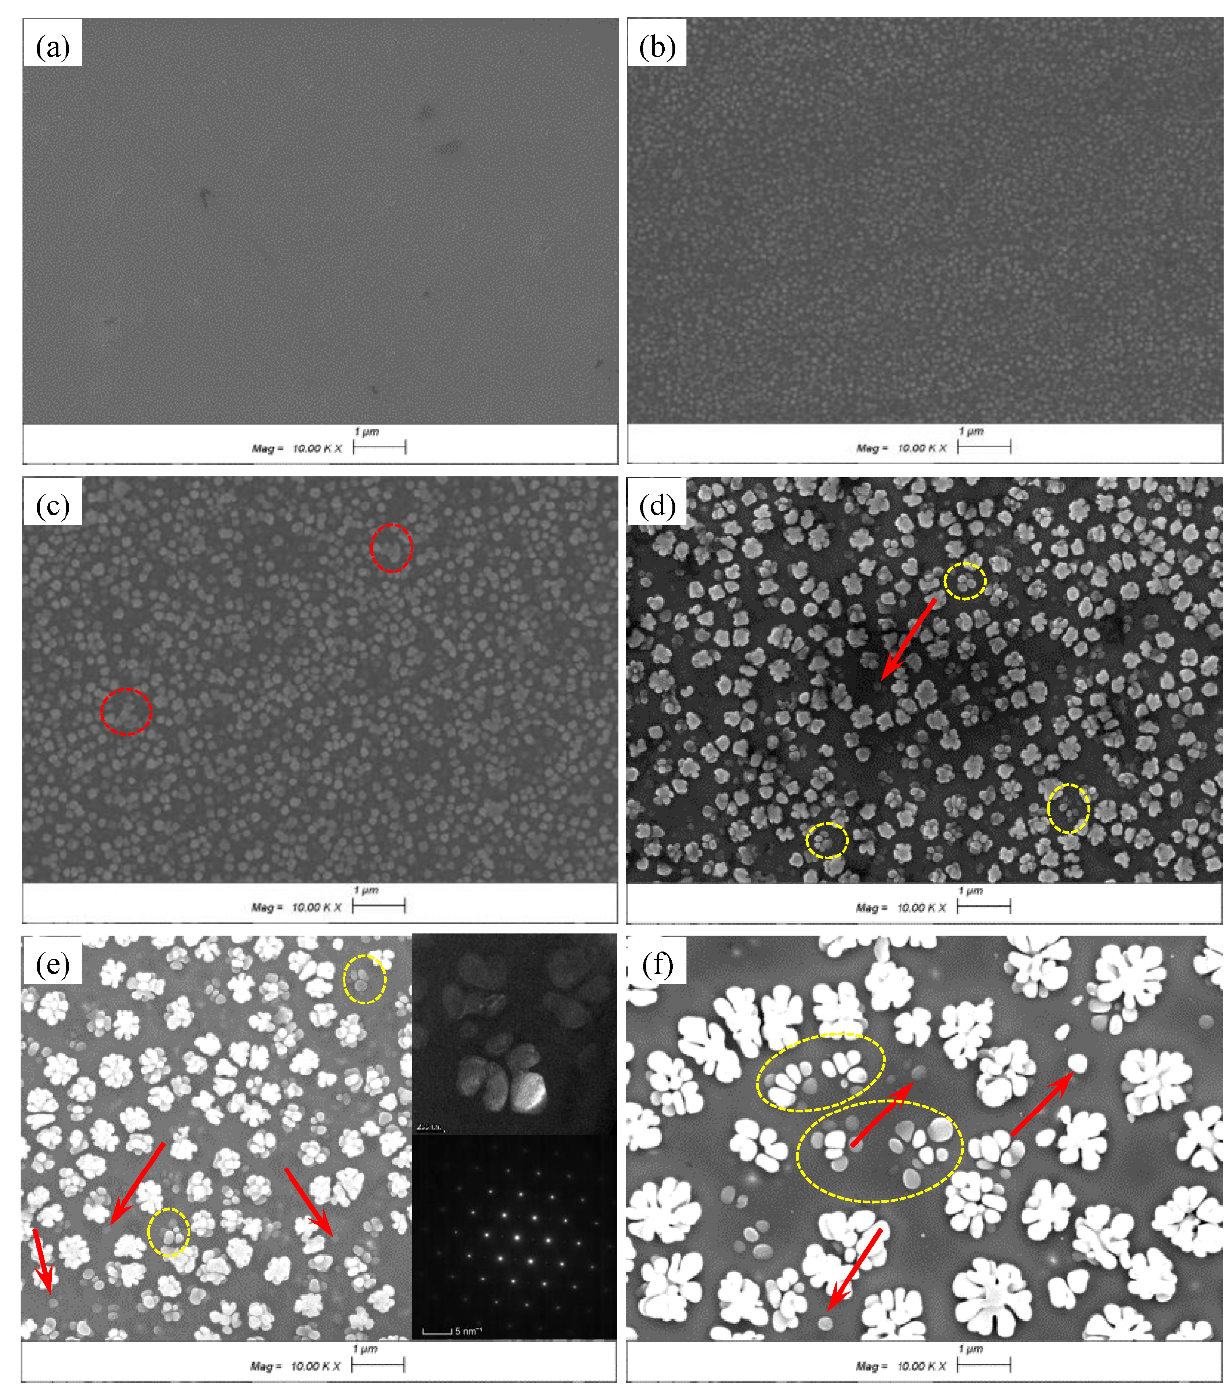
Figure 2. The evolution of the γ′ precipitates under different cooling rates. ( a ) Water quenched, ( b ) 20 °C/min, ( c ) 10 °C/min, ( d ) 5 °C/min, ( e ) 1 °C/min, and ( f ) 0.25 °C/min.